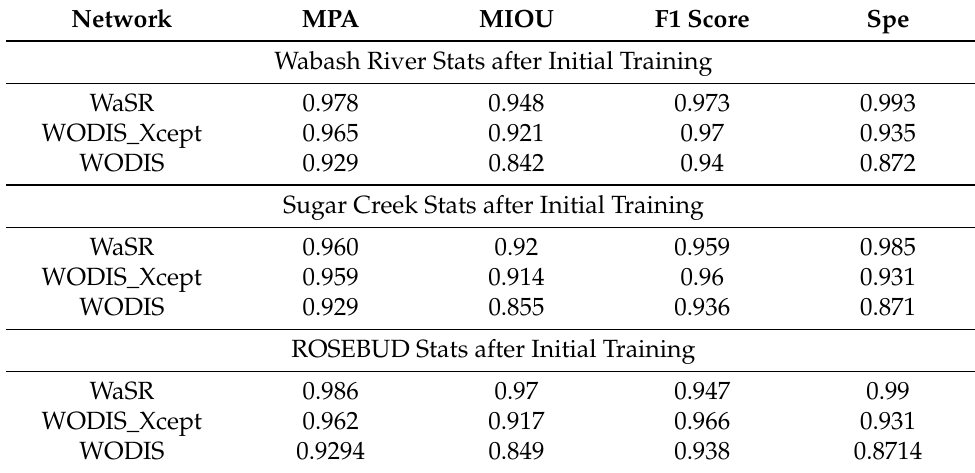
Table 3. Quantitative comparison of networks after completing training on the augmented dataset as detailed in Section 4.3 and summarized in Table 2. Each network was baselined against the Wabash and Sugar Creek Subsets of the ROSEBUD dataset as well as the dataset as a